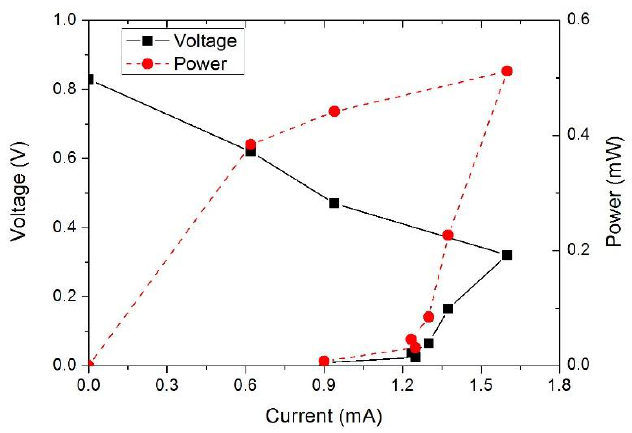
Figure 3. Output characteristics of the MFC.